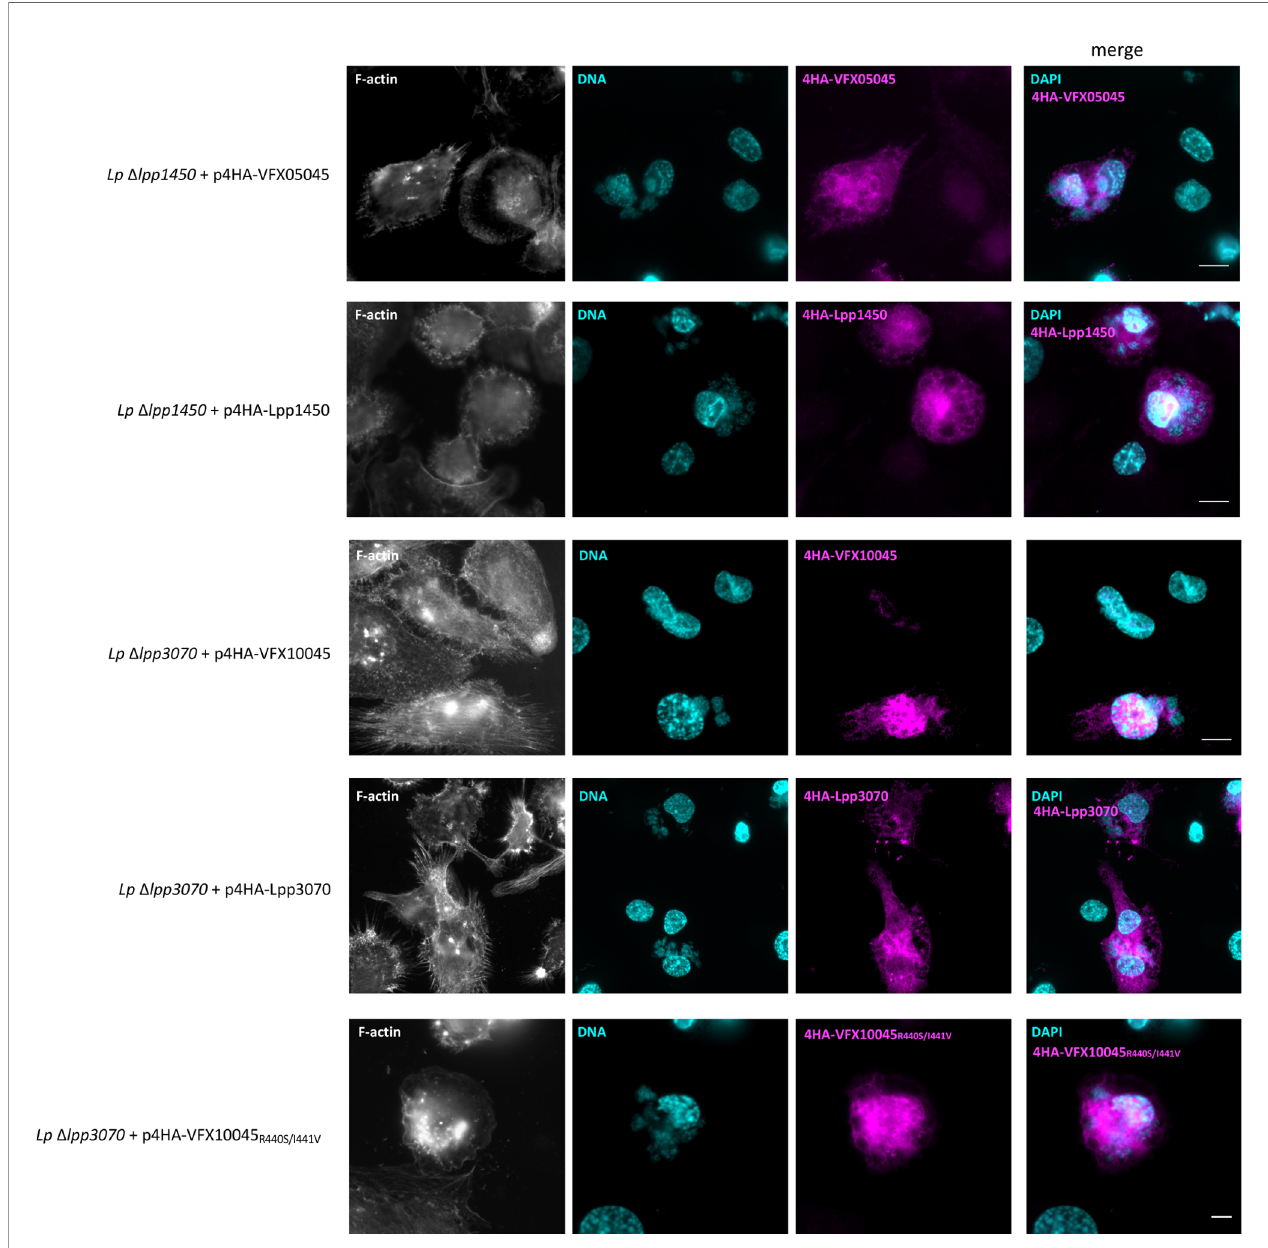
FIGURE 4 | Subcellular localization of L. pneumophila effectors VFX05045, Lpp1450, VFX10045 and Lpp3070 during infection of THP-1 cells. THP-1 cells were infected with the indicated L. pneumophila Paris derivative strains for 24 hours with multiplicities of infection of 5. Cells were fi xed with 4% PFA (w/v) and permeabilized with 0.1% Triton X100 (v/v). F-actin was labeled with Phalloidin-AlexaFluor-488 (shown in white), DNA was labeled with DAPI (in cyan) and translocated HA-tagged effectors were labeled with primary anti-HA (rat) and secondary anti-rat-RRX antibodies (in magenta). Scale bar, 10